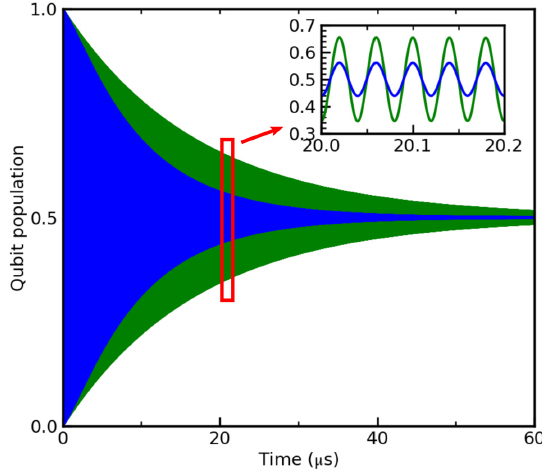
FIG. 17. Results of numerical simulations of the qubit evo- lution under a strong Rabi drive. The population of the qubit state | 0 (cid:7) is shown as a function of the Rabi pulse duration. The blue line represents the Rabi decay of a qubit coupled to an off- resonant TLS defect when the pulse amplitude (Rabi frequency) is equal to the qubit-defect detuning ( (cid:11) L = (cid:10) ). The green curve corresponds to the Rabi decay of a bare qubit ( (cid:11) L (cid:8)= ± (cid:10) ). Inset: an enlarged view showing Rabi oscillations in the range of pulse duration values close to 20 µ